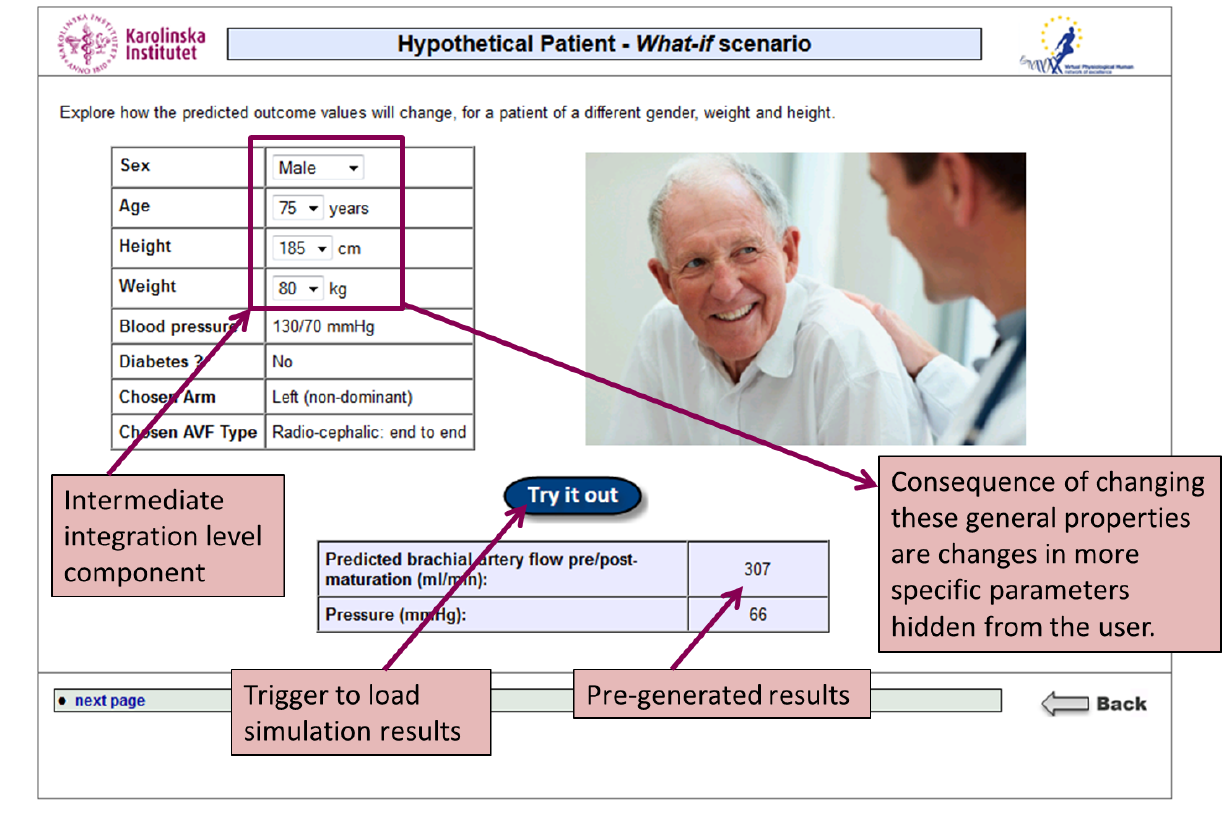
Figure 5. Second level computational model integration ("what-if-node") for the VPH ARCH project virtual